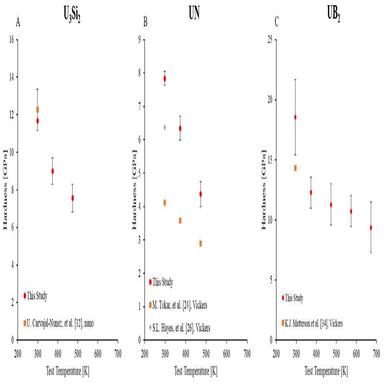
The temperature-dependent nanoindentation hardness of the ATF candidates. At each test temperature on each sample a minimum of 16 indents was performed with a 20 μm spacing. (A) U3Si2, (B) UN, and (C) UB2.